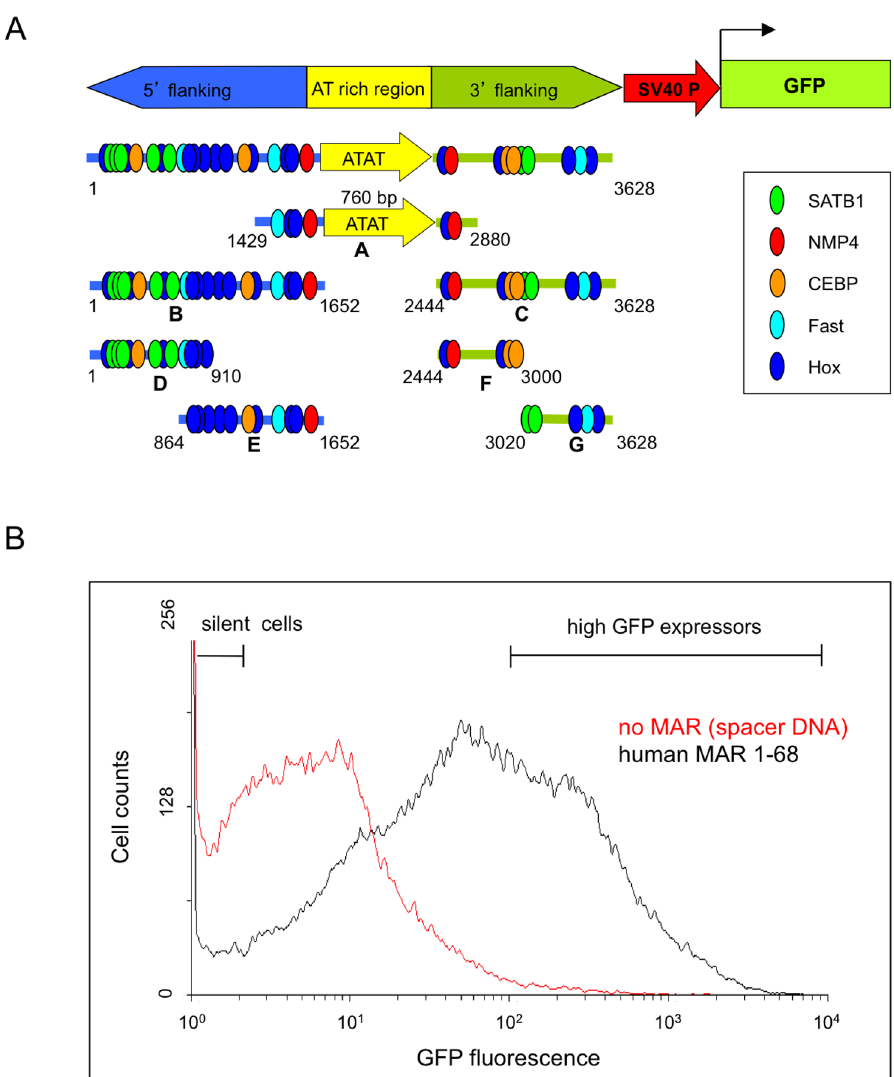
Figure 1. Schematic representation of MAR 1–68 subdomains and illustration of its anti-silencing and transcriptional effects. (A) Schematic diagram representing the full-length human MAR 1–68 and its series of sub-fragments, cloned upstream of a minimal SV40 promoter and EGFP reporter gene. The 3.6 kb MAR 1–68 was subdivided into three regions: The MAR 1–68 ‘‘extended AT core’’ region encompassing the AT dinucleotide-rich sequence (yellow box, labelled A), its 5 9 (blue, labelled B) and 3 9 (green, labelled C) adjacent regions. Putative transcription factor binding sites for the SATB1, NMP4, CEBP, Fast and Hox transcription factors are illustrated by ellipses. The 5 9 and 3 9 flanking regions were further divided in portions comprising nt 1–910 (labelled D), nt 864–1652 (E), nt 2444–3000 (F) and nt 3020–3628 (G). (B) A typical flow cytometry profile of CHO DG44 cells stably co-transfected with the GFP expression vector containing full-length human MAR 1–68 (black line) or control spacer DNA (no MAR, red line) and with a neomycin resistance plasmid. 10 5 cells were subjected to flow cytometry analysis for GFP expression after 2 weeks of nemomycin selection. Cells displaying background fluorescence (silent cells) or high GFP expression levels are as indicated.